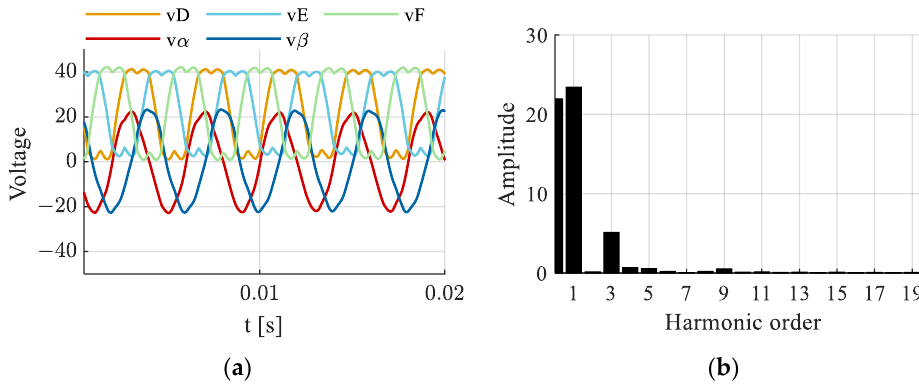
Figure 10. Measured voltages during the steady-state six-phase operation: ( a ) measured phase volt- ages and their transformed α–β components; ( b ) frequency spectrum of the measured voltage vF.